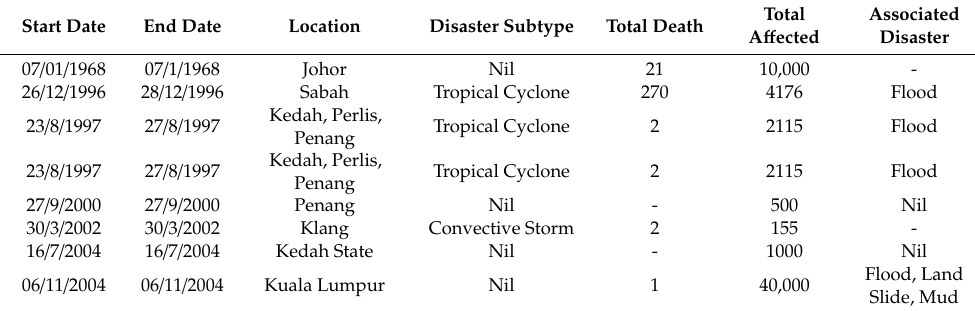
Table 1. Windstorm Disaster in Malaysia between 1960–2005 [6].